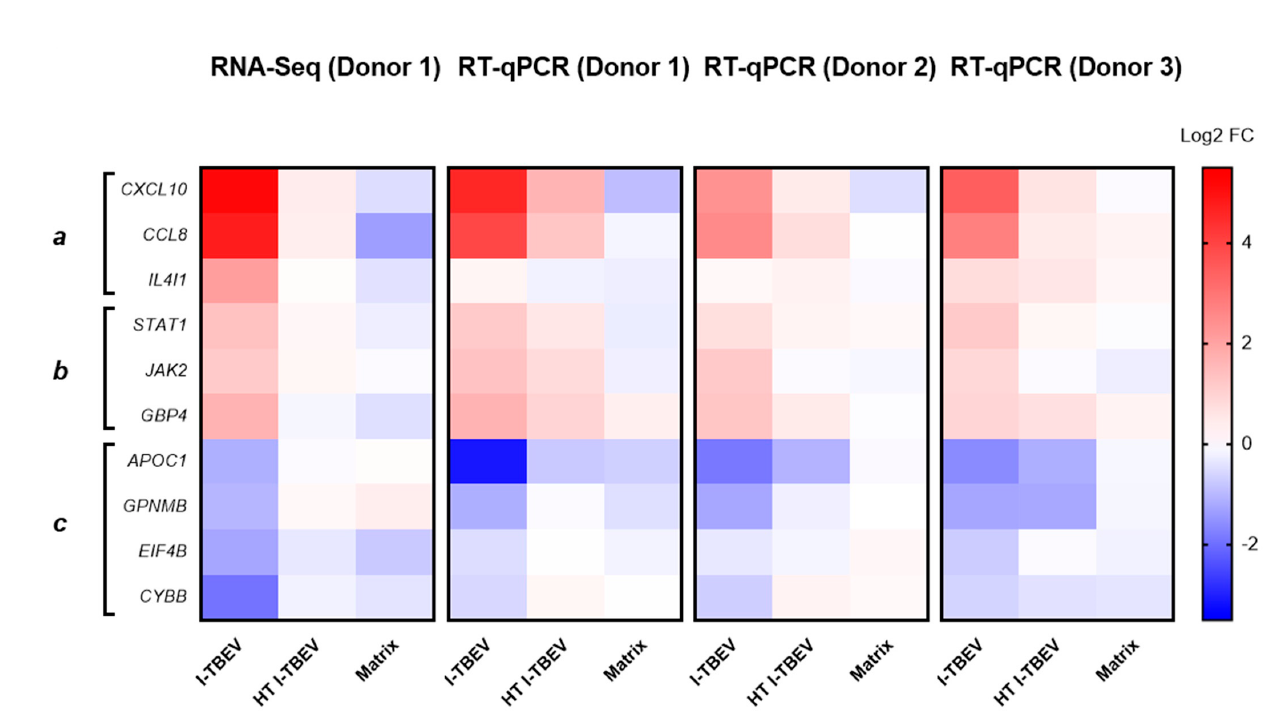
Figure A2. Validation of selected genes identified by RNA-Seq through RT-qPCR. The fold change in PBMCs from 3 donors (including the one used in the RNA-Seq analysis, donor #1) was analyzed in duplicate for each gene and treatment. The clusters represent functions upregulated ( a , b ) and downregulated ( c ) by I-TBEV. Results are shown as heatmap (normalized to the expression in the non-treated samples, set as FC = 1), and compared to the RNA sequencing data.